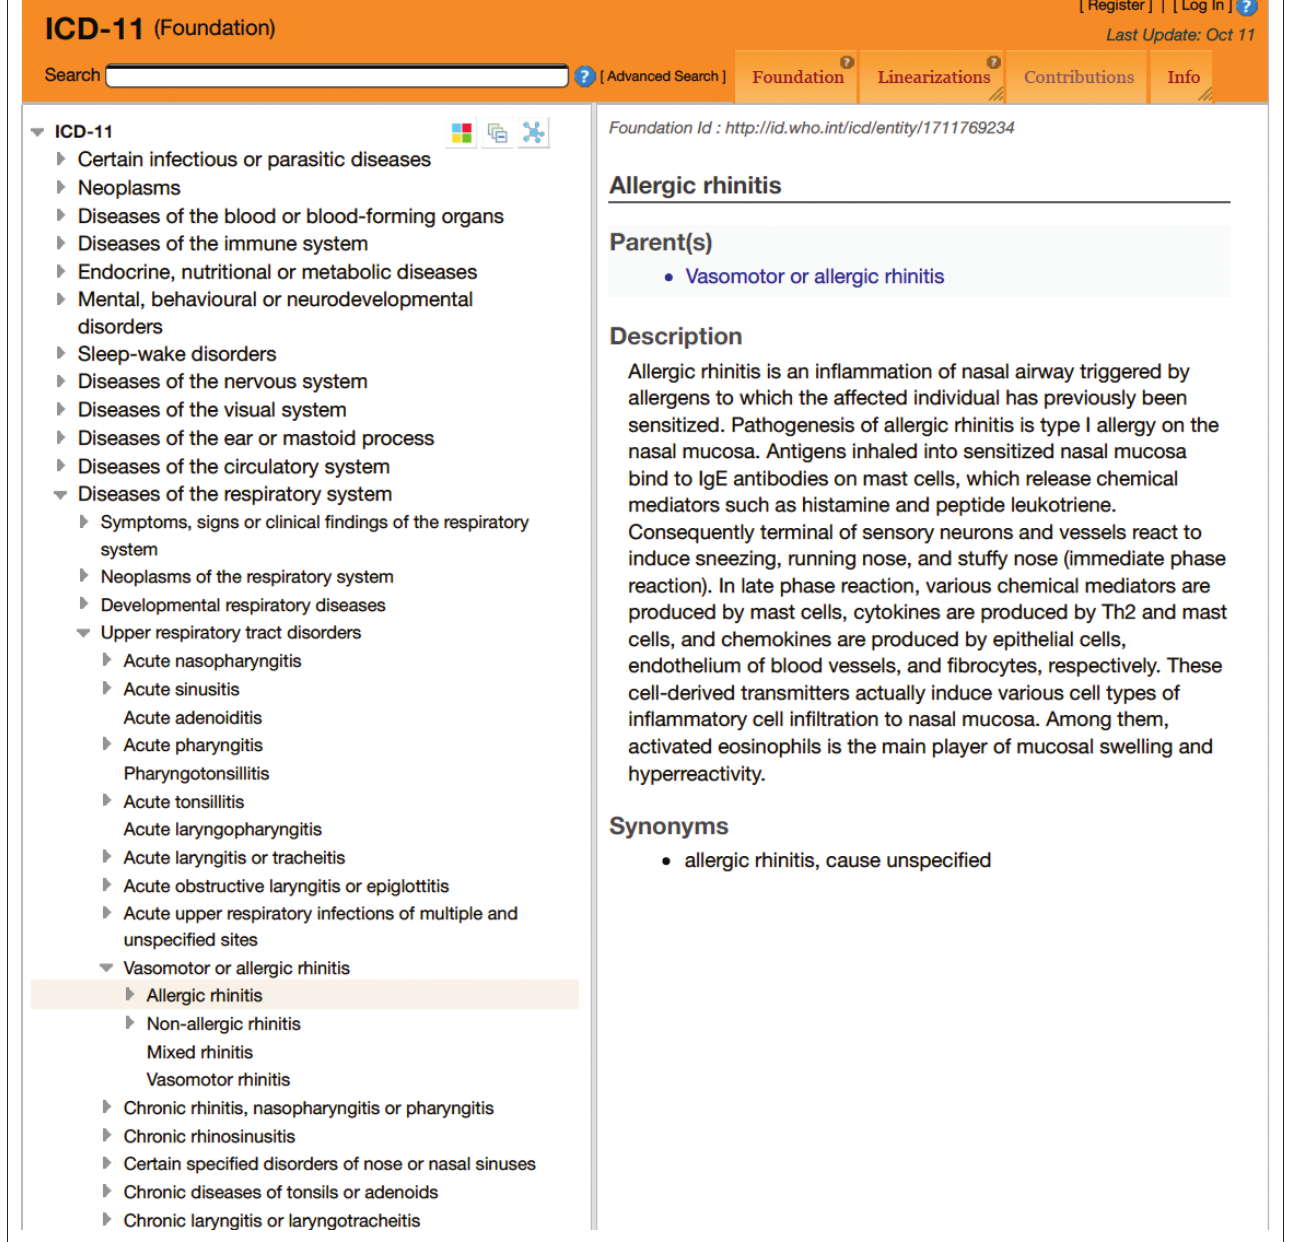
FIGURE 1: International Classification of